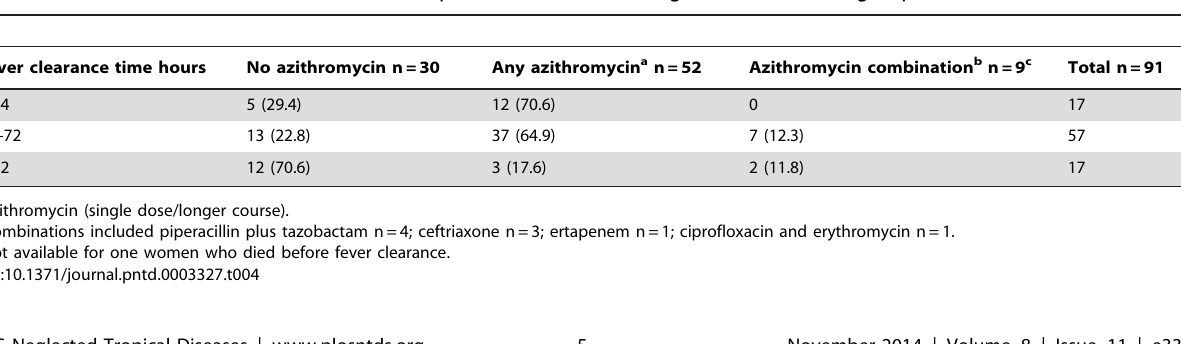
Table 4. Fever clearance times (hours) from all published data according to the treatment group.